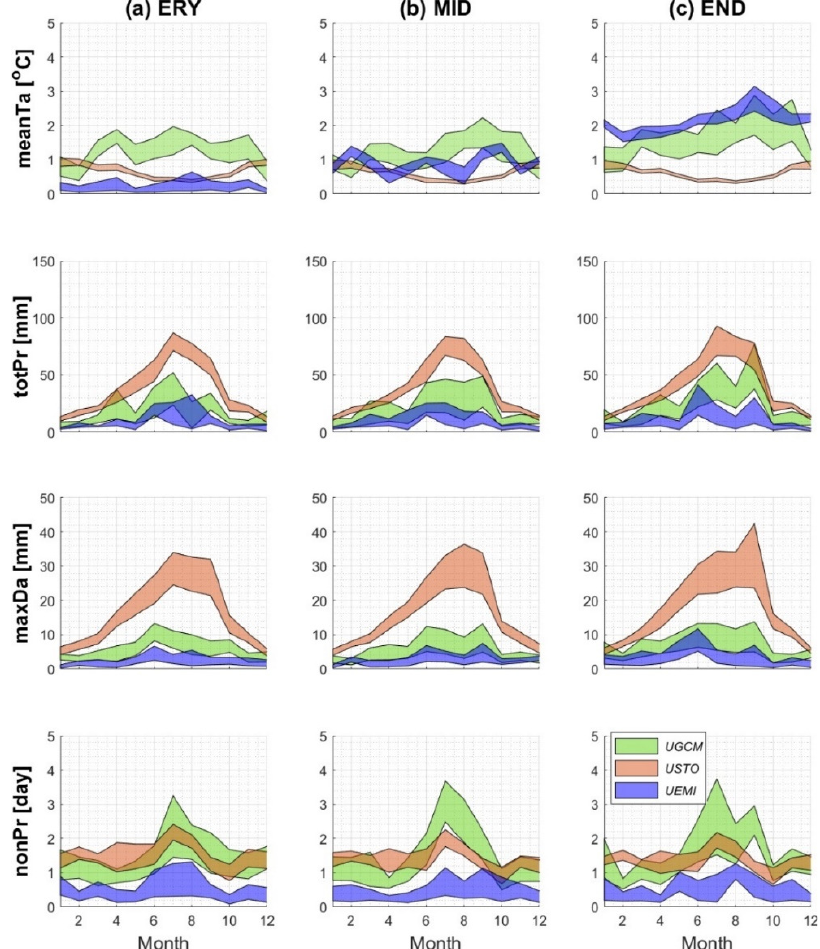
Figure 12. Comparisons of monthly uncertainties, including climate model uncertainty ( UGCM ), stochastic uncertainty ( USTO ), and emission scenario uncertainty ( UEMI ) for 4 indices for the ( a ) ERY, ( b ) MID, and ( c ) END periods. For each month, the shaded area was computed as the difference between the 25th and 75th percentiles of 40 values across South Korea.